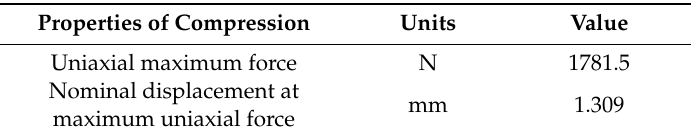
Table 10. Mechanical properties for the printed end part achieved in the uniaxial compression test in